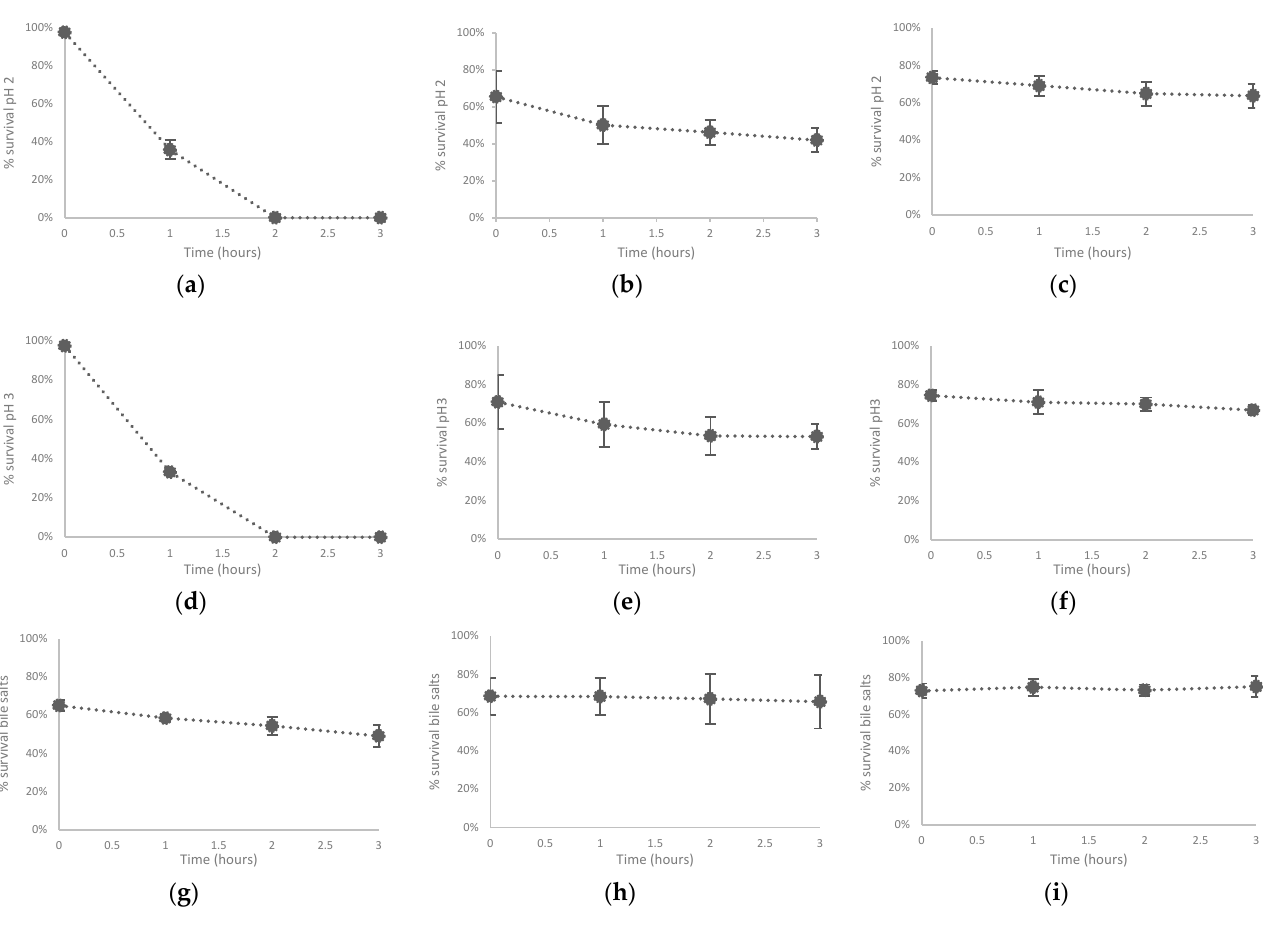
Table 4. Hydrophobicity evaluation of A12, M4, and M10. Bacteria